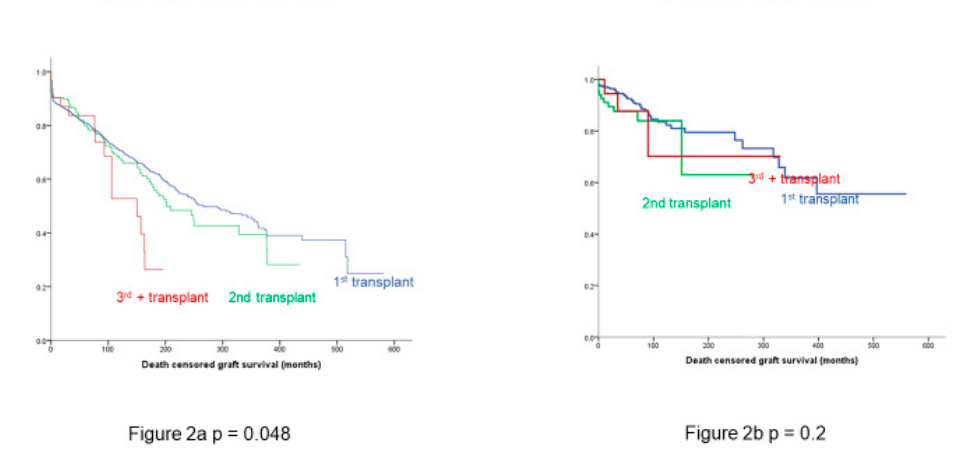
Figure 2. Di ff erence in death-censored graft survival is seen in deceased donor transplants ( a ) but not in kidneys retrieved from living donors ( b ). Prolonged ischaemia is significantly detrimental to long-term survival in deceased donor grafts and 3rd and 4th transplants are associated with prolonged ischaemic times. These are marginal patients with di ffi cult vasculature—marginal kidneys do less well in this context while good kidneys cope fine. Blue line: recipients of 1st kidney transplant; green line: recipients of 2nd kidney transplant; red line: recipients of 3rd kidney transplant.